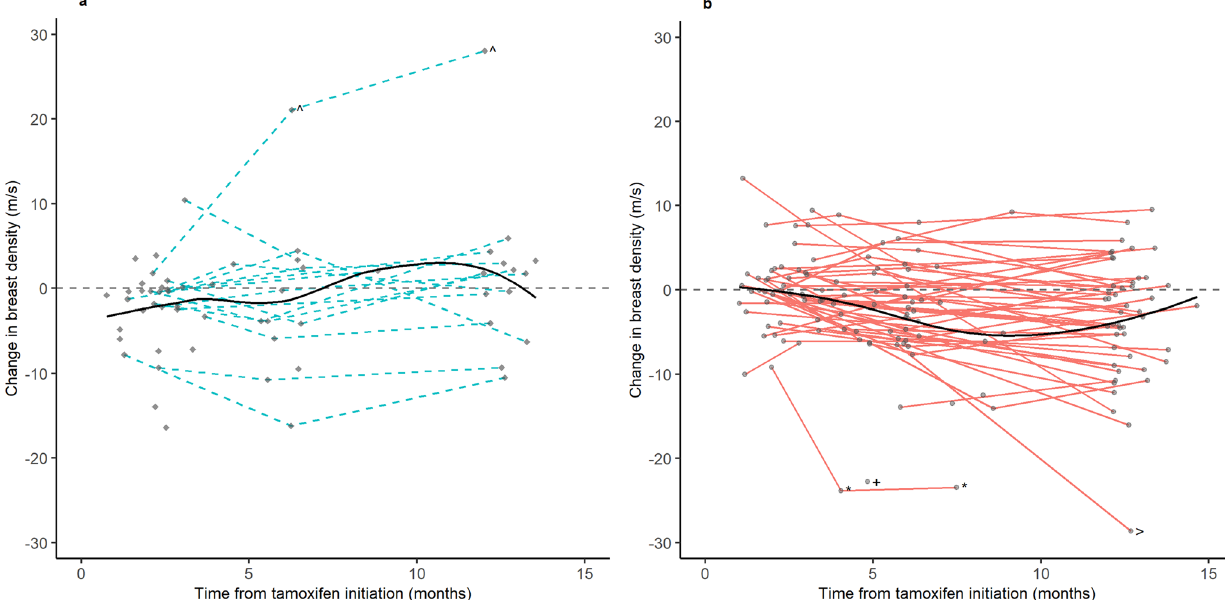
Fig. 1 Trajectories of change in breast sound speed (m/s) by treatment-associated symptoms. a No treatment-associated symptoms. b Treatment-associated symptoms. Treatment-associated endocrine symptoms were de fi ned as either emergent or worsening vasomotor symptoms and/or joint pain after tamoxifen initiation. Loess curve was fi t between change in breast sound speed and time from tamoxifen initiation. Extreme values for change in breast sound speed (m/s) are indicated with symbols. Each symbol represents an observation from the same women. The caret represents a woman with an extreme value of breast sound speed increase and who reported weight loss from T0 to T2 of approximately 20 lbs. and T0 to T3 of 25 lbs. The plus, asterisk, and angle bracket symbols represent three separate women with an extreme value of breast sound speed decline and cessation of menstrual periods by T3.